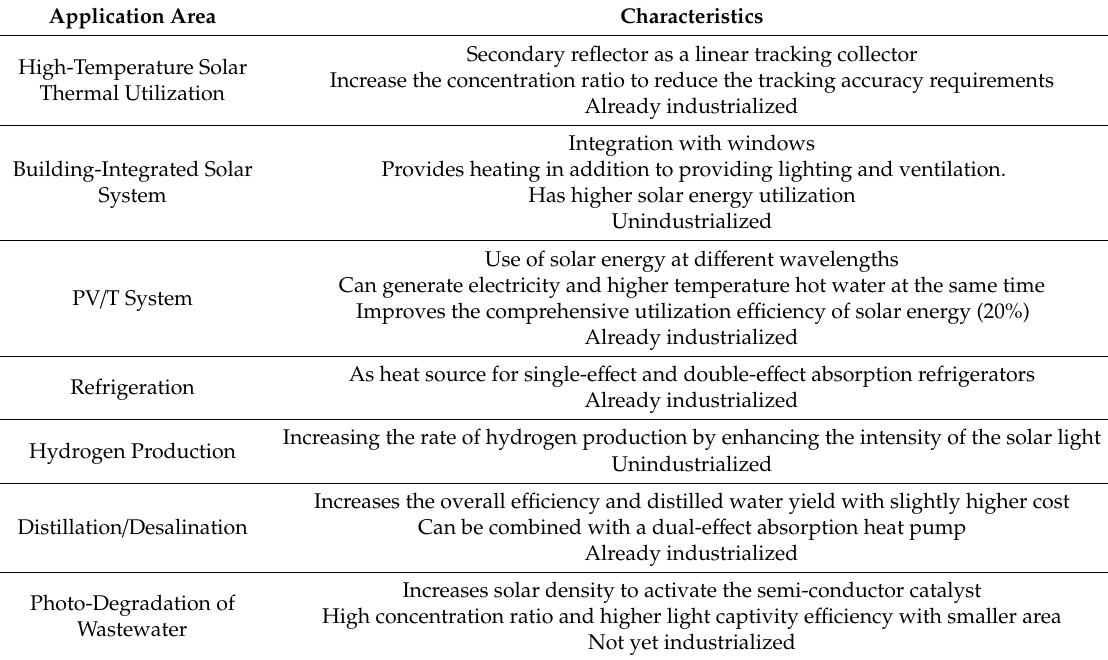
Table 7. Summary of tubular absorber CPC modules in different application areas.